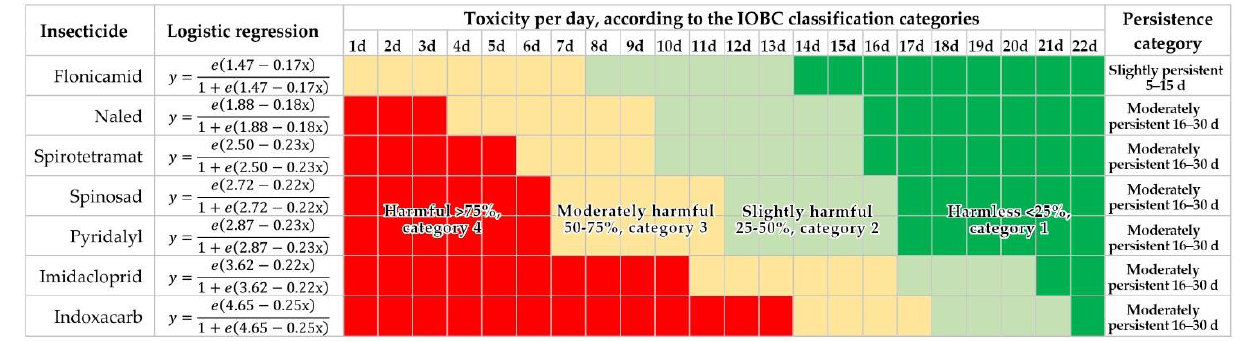
Figure 2. Toxicity and persistence of insecticides on Diadegma insulare using the IOBC classifica- tion.